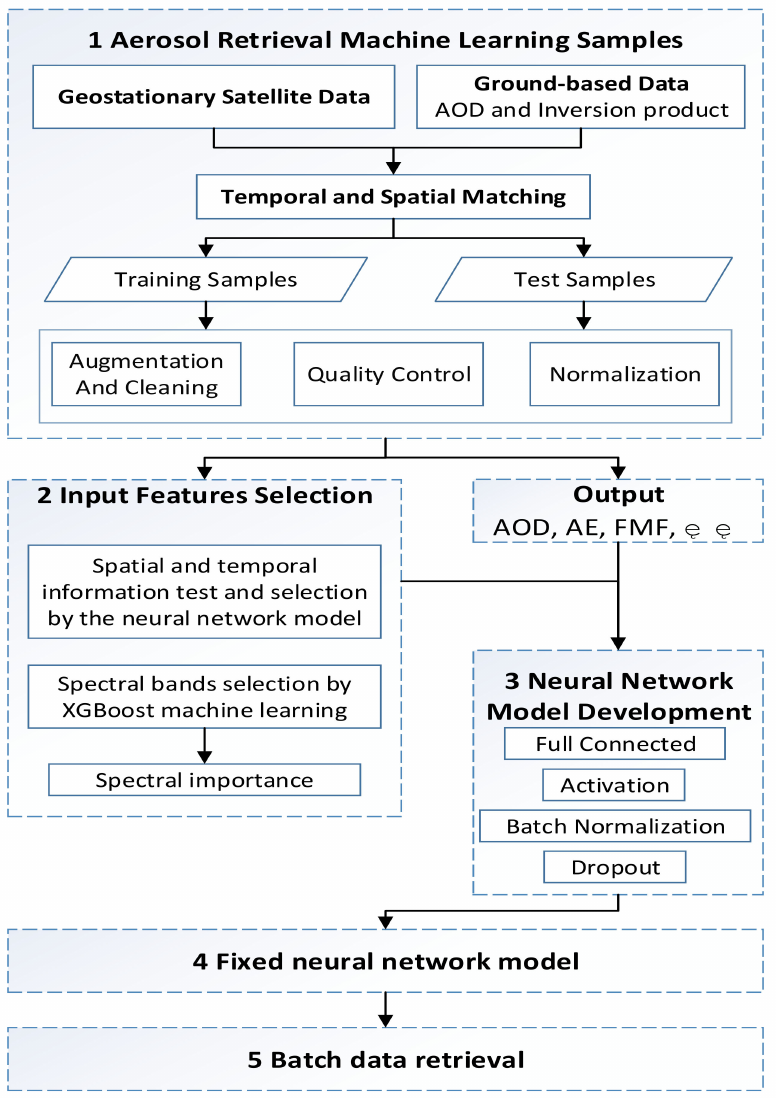
Figure 2. Flowchart of NNAeroG